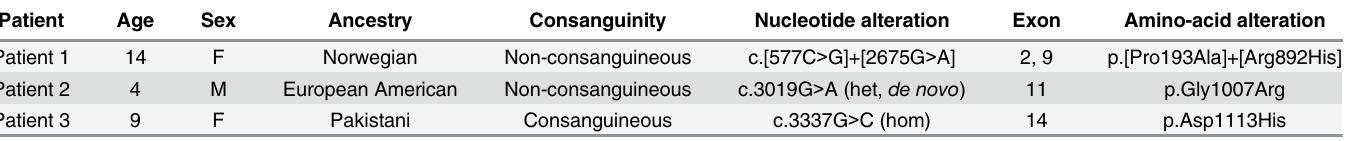
Table 1. Demographic data, ancestry, and sequence alterations in ADAR1 mutation – positive